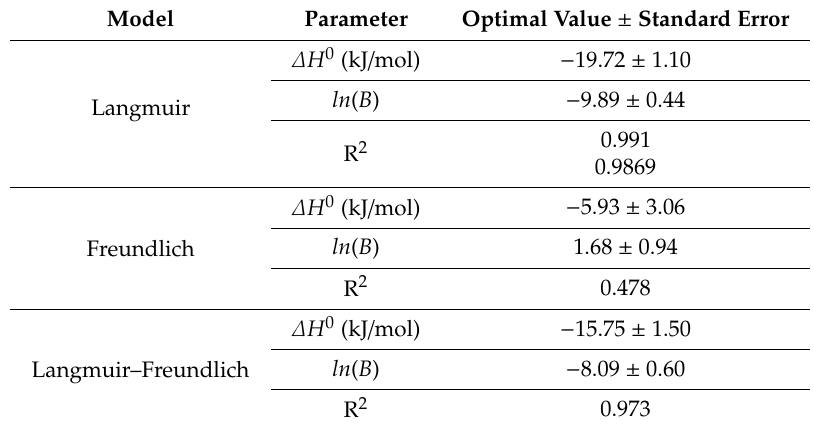
Table 3. Thermodynamic parameters for the MB sorption onto BP.